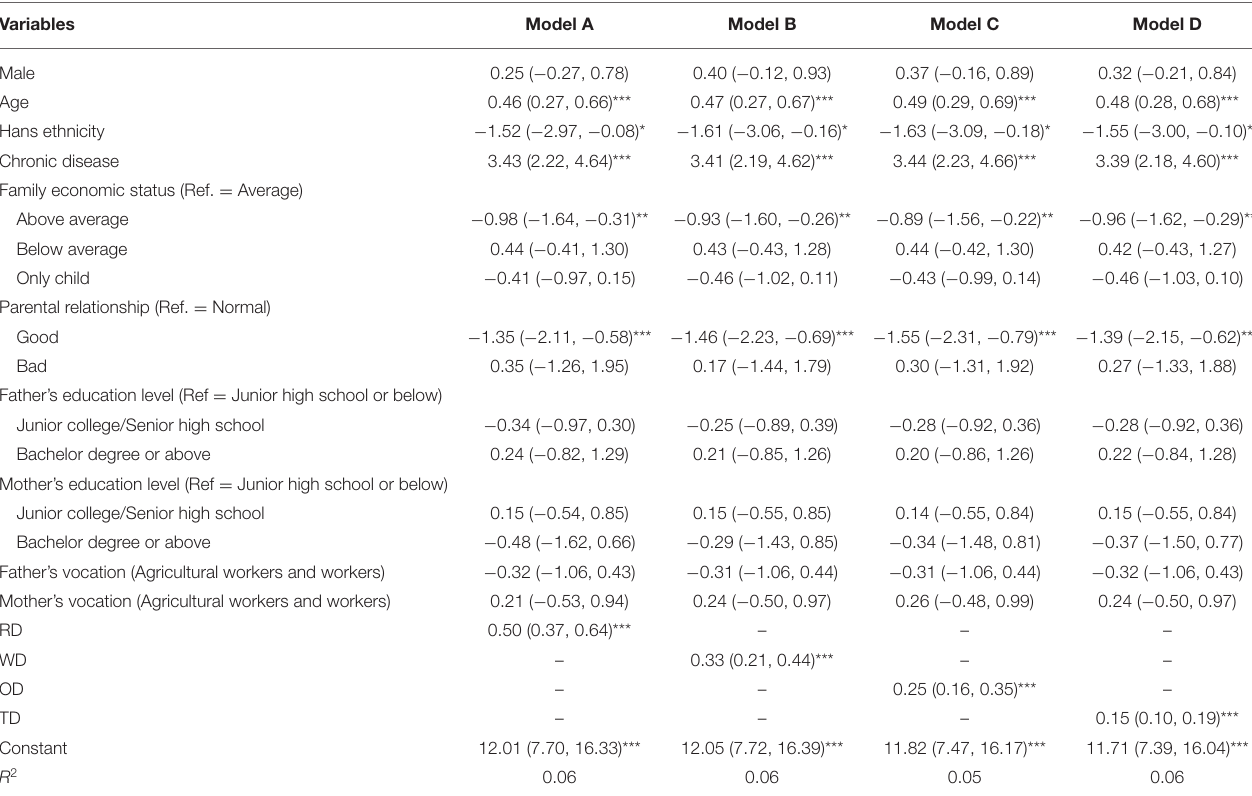
TABLE 3 | Linear regression for the association between parental parenting style disparities and mental health ( β and its 95%